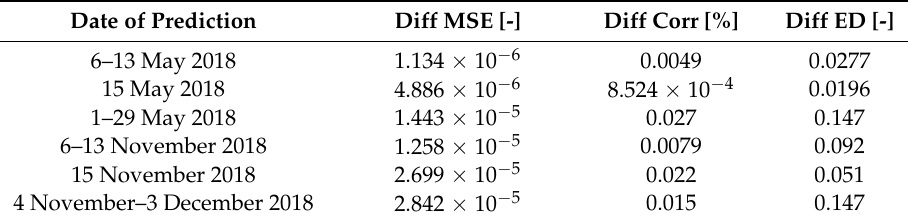
Table 12. The difference parameters of CO 2